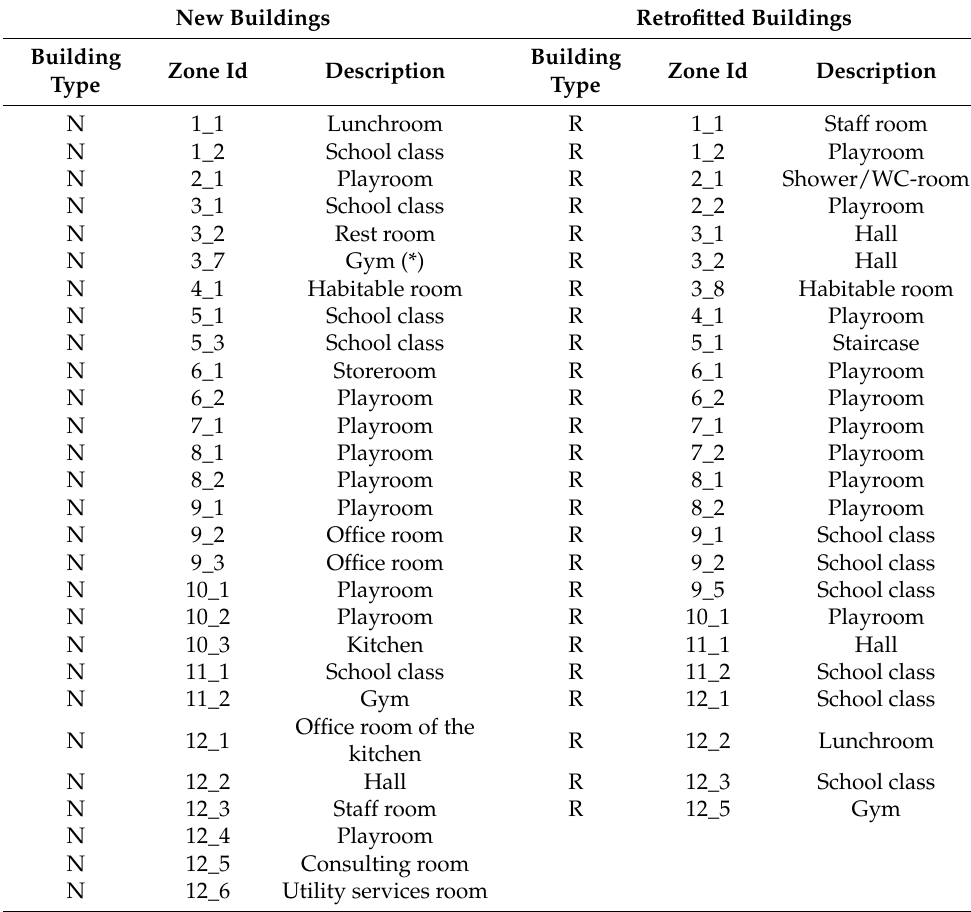
Table A3. A listing of the zones that were monitored in the measurement campaign. N = New building, R = Retrofitted building. Zone id is of the format <building number>_<zone number>. (*) N_3_7 Gym was not included in the calculations on the difference of air pressure differences between top and bottom part of the wall (Figure